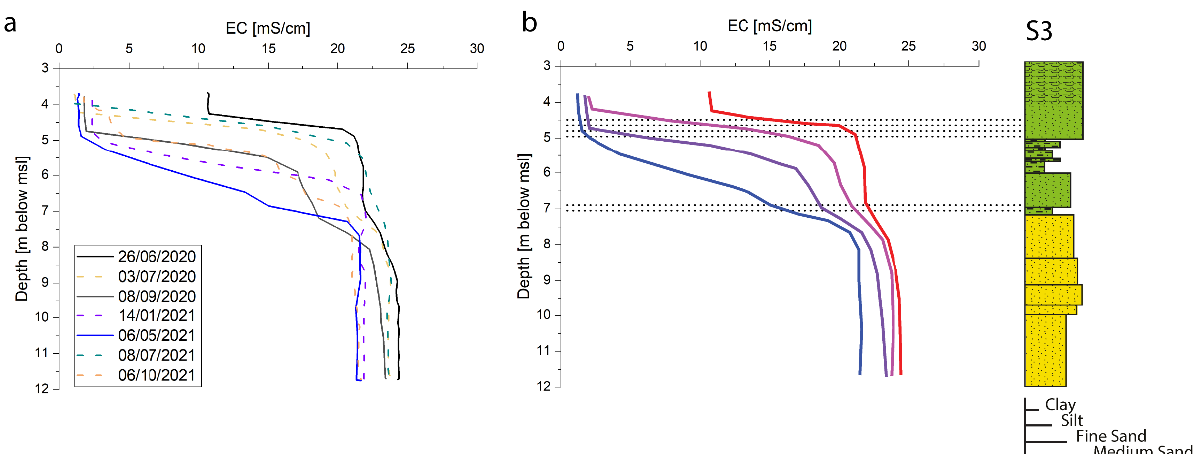
Figure 12 . EC profiles collected in S3 well. Panel ( a ) shows the configurations assumed by the EC curve during the observed period. The model of panel ( b ) summarizes the configurations and compares them with the stratigraphic section, outlining the sedimentary constraints (dotted areas) existing in the subsoil surrounding the monitoring point.